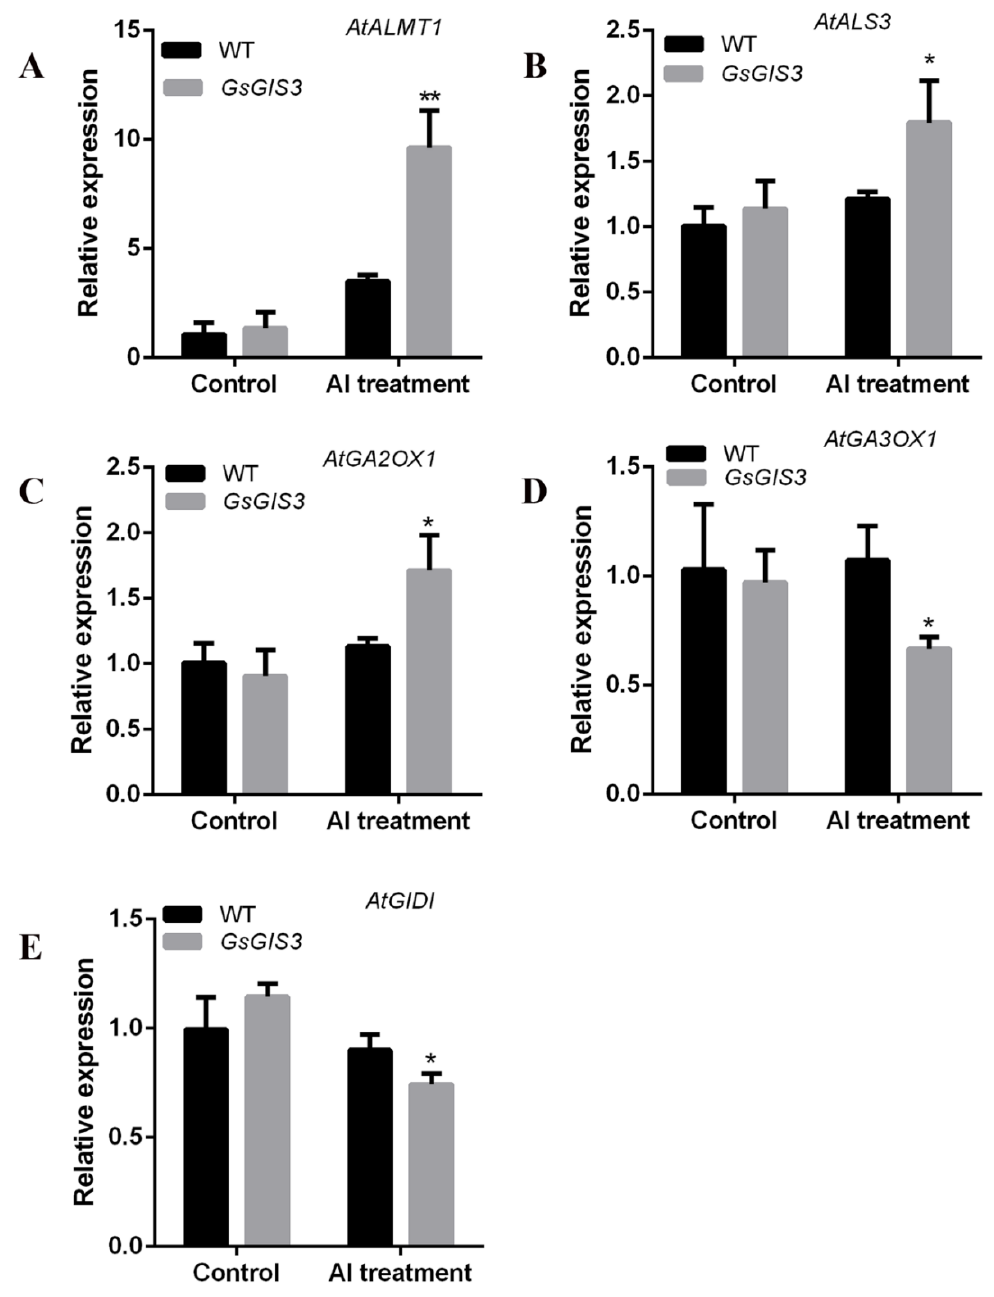
Figure 7. Expression Patterns of Al Stress / GA3-related Genes Regulated by GsGIS3 : ( A ) AtALMT1 expression; ( B ) AtALS3 expression; ( C ) AtGA2XO1 expression; ( D ) AtGA3OX1 expression; and ( E ) AtGID1 expression. Asterisks indicate a significant difference (* P < 0.05; ** P < 0.01) compared with the controls.